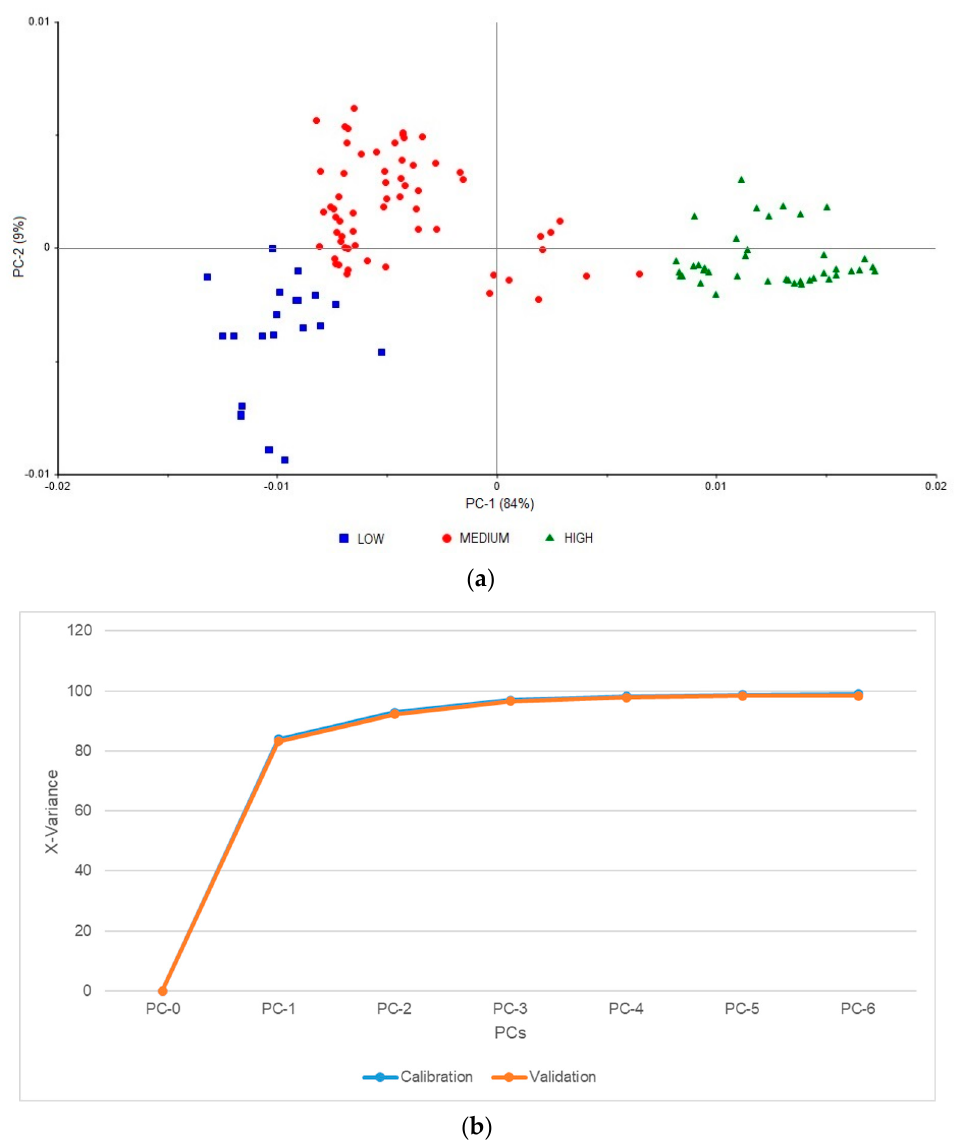
Figure 4. The ( a ) score plot color-coded according to clusters and ( b ) explained variance of the PCA result.